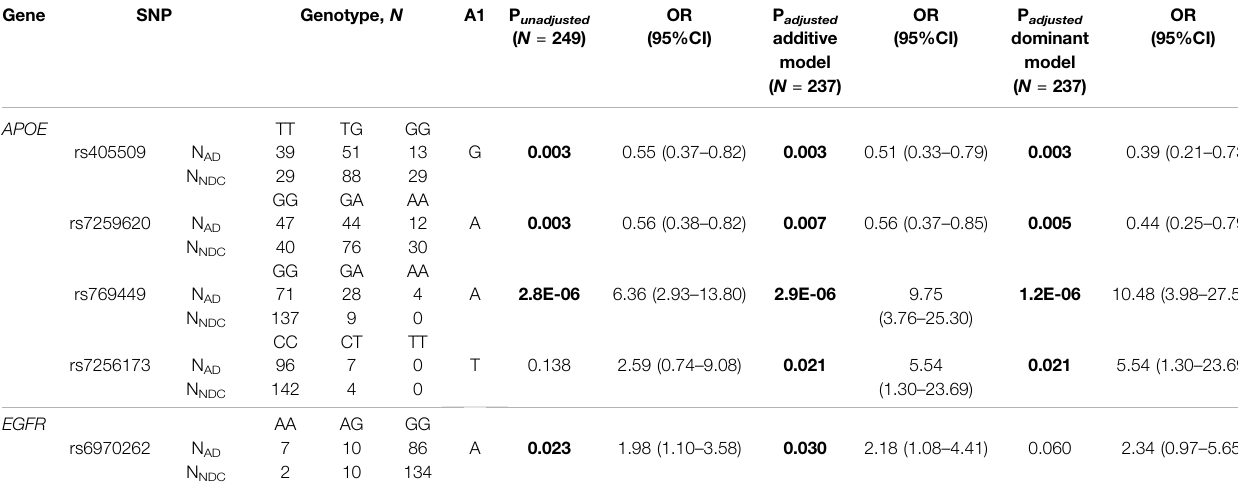
OR:oddsratio;CI:con fi denceinterval;A1:minor/effectallele;N AD :GenotypesnumberinAD;N NDC :Genotypesnumberinnon-dementedcontrols;P adjusted : p valuesadjustedwithage, gender and education status in logistic regression analysis. Bold signi fi es p < 0.05. Additive model is based on the additive effects of allele dosage. Dominant model assumes the full dominance for the minor allele. The OR > 1, means A1 increases relative risk relative to A2. All values are calculated using PLINK, 1.09.